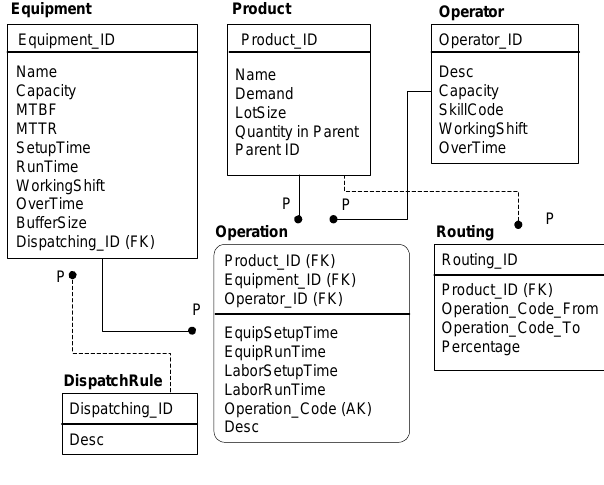
Figure 7. “IDEF1X data model for case